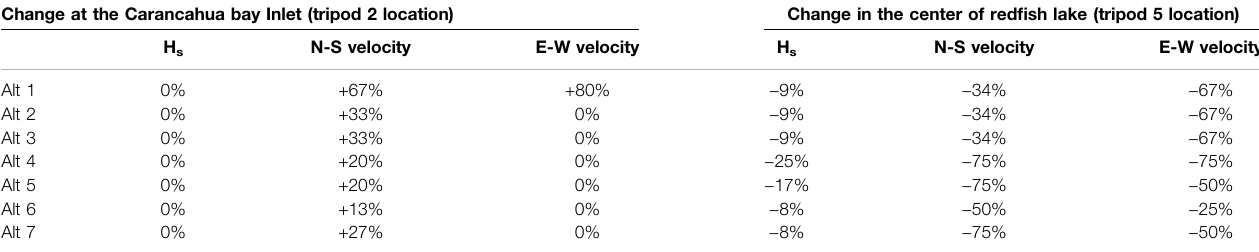
TABLE 4 | The effect of various design alternatives on existing waves and fl ow velocities. Change at the Carancahua bay Inlet (tripod 2 location) Change in the center of red fi sh lake (tripod 5